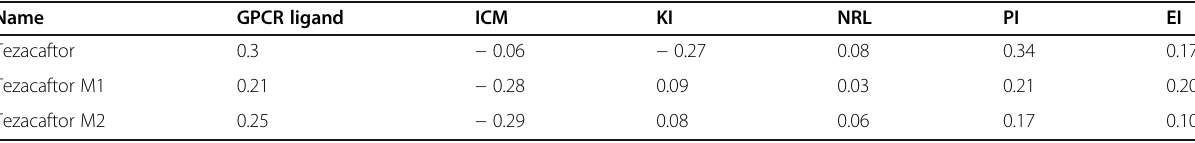
Table 16 Bioactivities of Tezacaftor and its metabolites based on the drug likeness score were calculated using Molinspiration